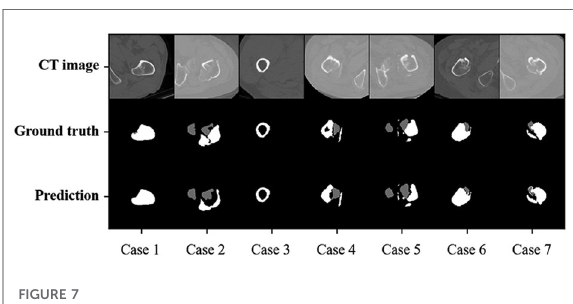
FIGURE 7 Automatic and manual labeled masks in local test dataset.